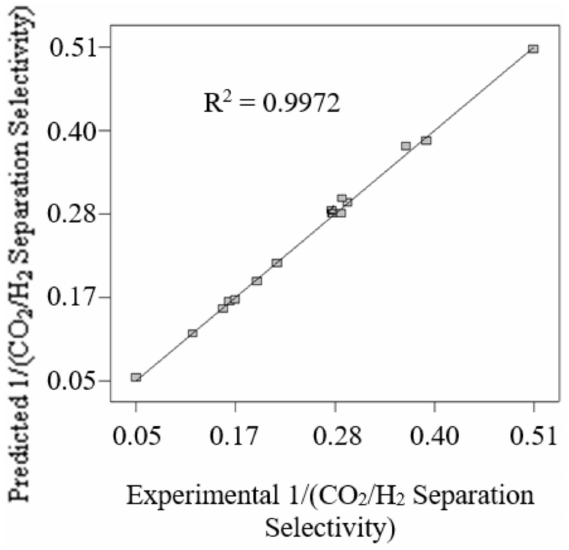
Figure 5. The comparison of the predicted 1/(CO 2 /H 2 separation selectivity) attained by using Equation (7) with the experimental 1/(CO 2 /H 2 separation